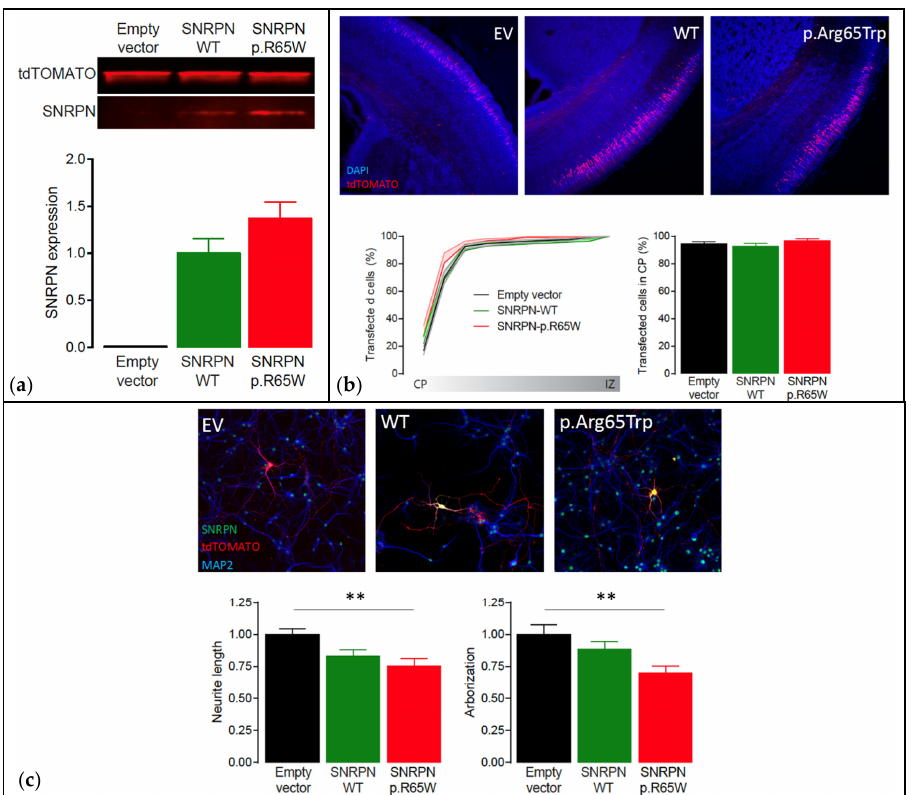
Figure 5. Functional analysis using the PR i SM screen. Abbreviations: Empty vector (EV), wild type (WT). ( a ) Western blot analysis of transfected HEK293T cells showing that SNRPN expression is normal. Top: Western blot of transfected HEK293T cells showing clear overexpression of SNRPN-WT and SNRPN-p.R65W . Bottom: Quantification of the Western blots showing that the SNRPN-p.R65W missense variant does not alter the expression levels of SNRPN ( N = 4 per condition). ( b ) In utero electroporation of the different SNRPN constructs does not affect neuronal migration in vivo. Top: Representative images from in utero electroporated postnatal brains on day 1. These images show that the far majority of the transfected cells (tdTOMATO+) migrated out to the cortical plate (CP; the outer layer of the cortex). Bottom left: Cumulative distribution of the transfected neurons at P1 from the cortical plate (CP; the outer layer of the cortex) to the intermediate zone (IZ; inner layer of the cortex). Bottom right: Percentage of neurons that migrated out to the superficial layers of the cortex (sum of bins 1 through 4). Number of pictures/animals for each condition = 9/3. ( c ) Expression of the different SNRPN constructs in mouse primary hippocampal neurons reveal that overexpression of the p.Arg65Trp variant significantly affects neuronal maturation in vitro. Top: Representative images of primary hippocampal neurons transfected with Empty vector control, SNRPN-WT or SNRPN-p.Arg65Trp (tdTOMATO+). Neurons are stained for SNRPN (green) and MAP2 (blue). Bottom: Quantitative analysis of the total neurite length and arborization in the different conditions. Number of neurons/number of batches for each condition = 20/2; ** p <